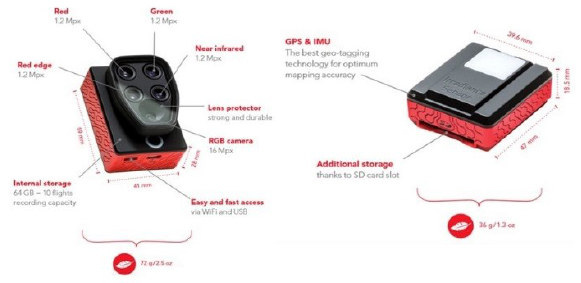
Fig 1. Parrot Sequoia The micro MCA multispectral camera has six separate cameras. Each camera is synchronized with the other cameras so that each can capture the same scene at the exact same time of exposure. During each exposure instant, six separate channels of visible or NIR radiation move through each lens and filter to form separate monochromatic images on each sensor.